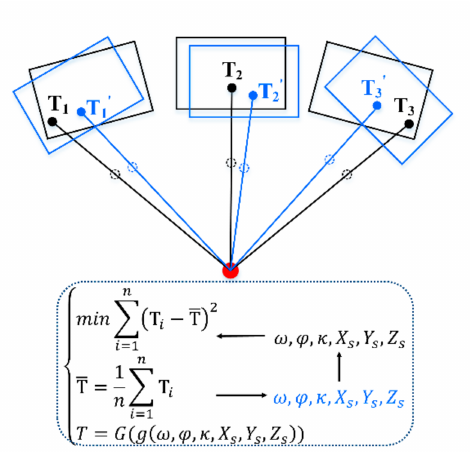
Figure 6. Illustration for global pose refinement. Black box indicates the original image pose and blue box indicates the refined image pose after one-time iteration. T refers to temperature calculated from thermal